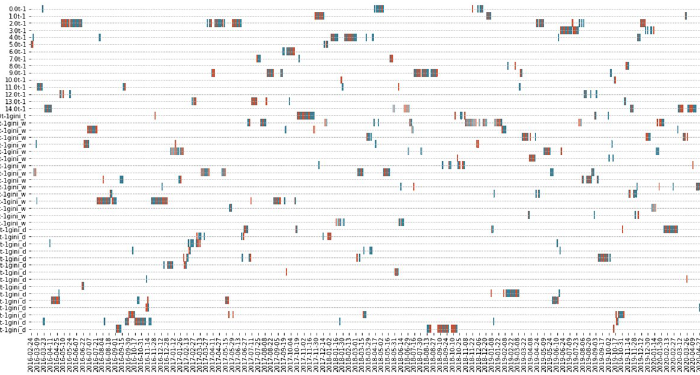
Fig 14. Different topic score models chosen for prediction in model 1 when threshold setting = 0. This graph shows the regressors chosen from model 1 with the window size of 60 days, assuming the threshold = 0. In the y-axis, the regressors 0.0t-1 to 14.0t-1 represent the Popularity measures, 0.0t-1gini_t represents the Topic Diversity measures, 0.0t-1gini_w to 14.0t-1gini_w represent Word Diversity and 0.0t-1gini_d to 14.0t-1gini_d represent Diversity-ranked Word Diversity. The red (blue) colour represents where the topic score (benchmark) model outperformed the benchmark (topic score) model.